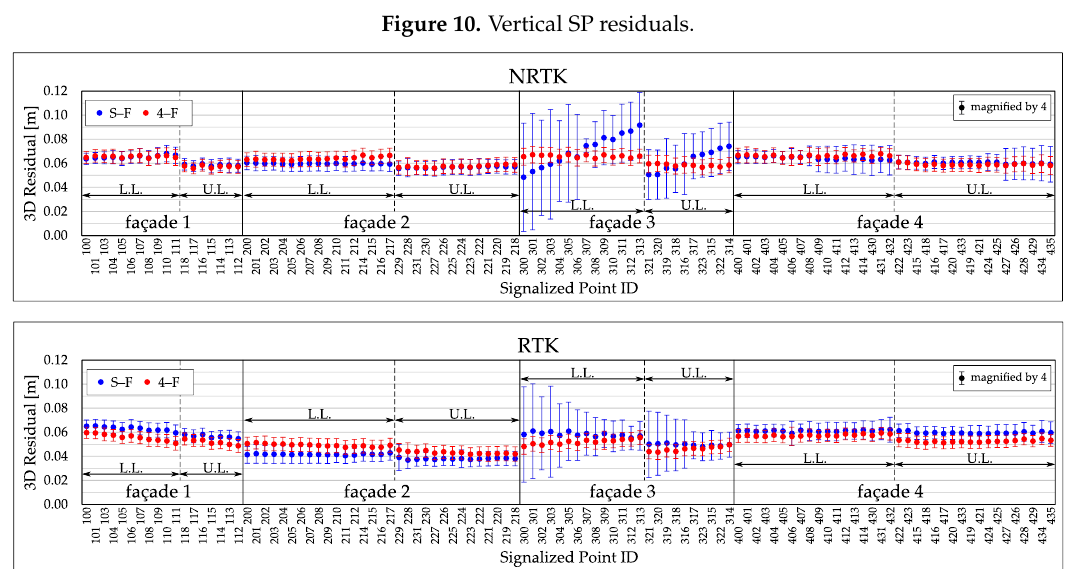
Figure 11. 3D SP residuals with standard deviation